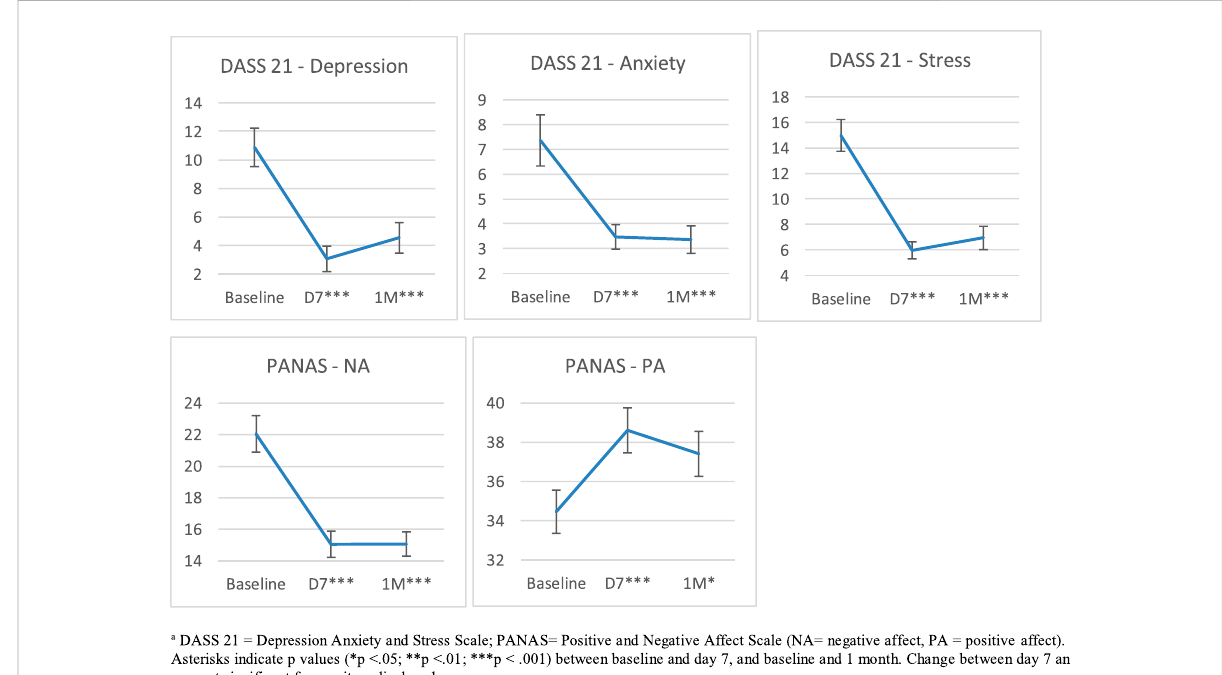
FIGURE 1 DASS 21 and PANAS mean scores at baseline, day seven (D7), and 1 month (1 M) a .